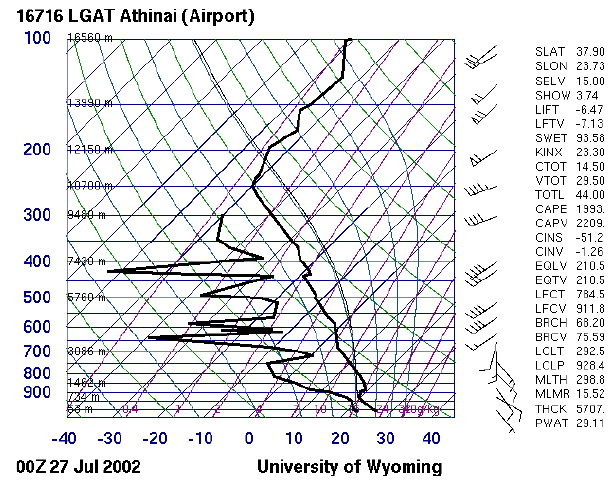
Figure 4. Skew-T plot and indices analysis for Athens at Figure 4. 00:00UTC, 27 July 2002, retrieved from the database of Wyoming University